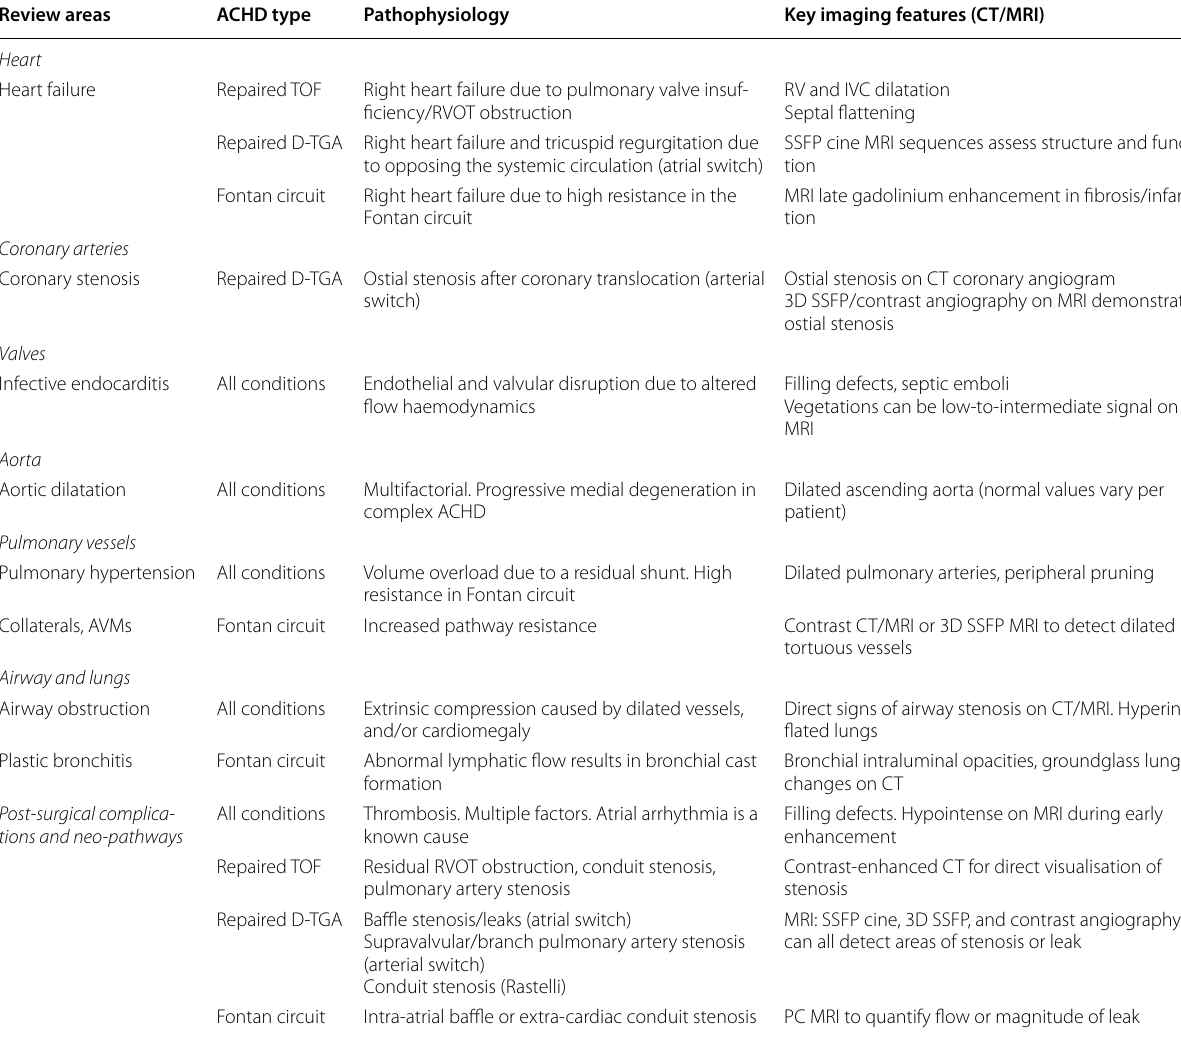
Table 3 Summary of complications by anatomical review area and repaired complex ACHD type Review